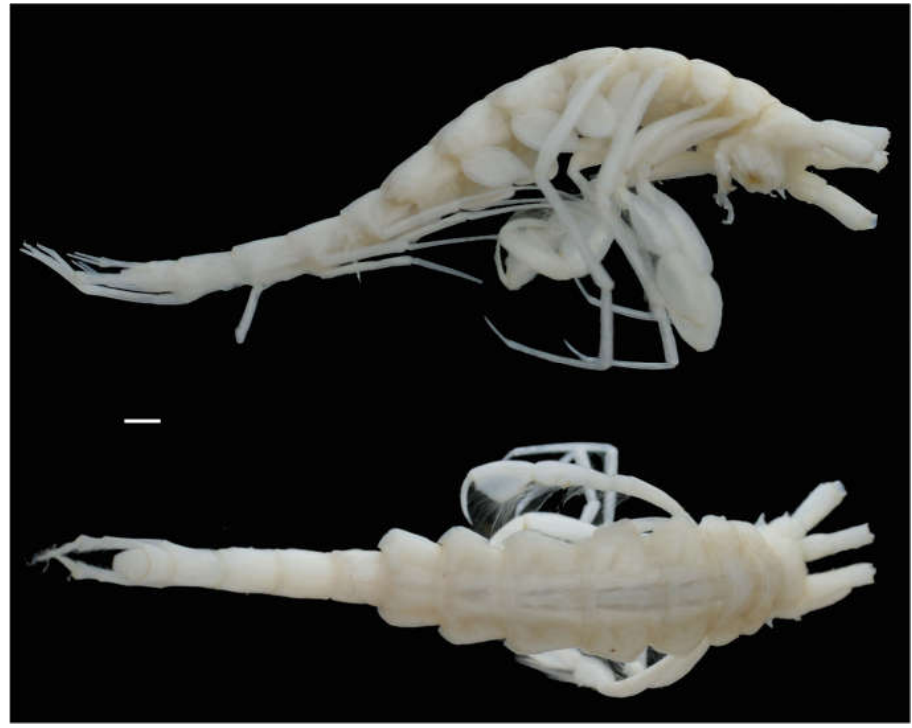
Figure 2. Photo image of Neohela monstrosa ( Boeck, 1861) male, 19 mm, SMF 52.259, Norwegian Sea, Norwegian Basin, North Atlantic, 1886 m. Scale: 1 mm.